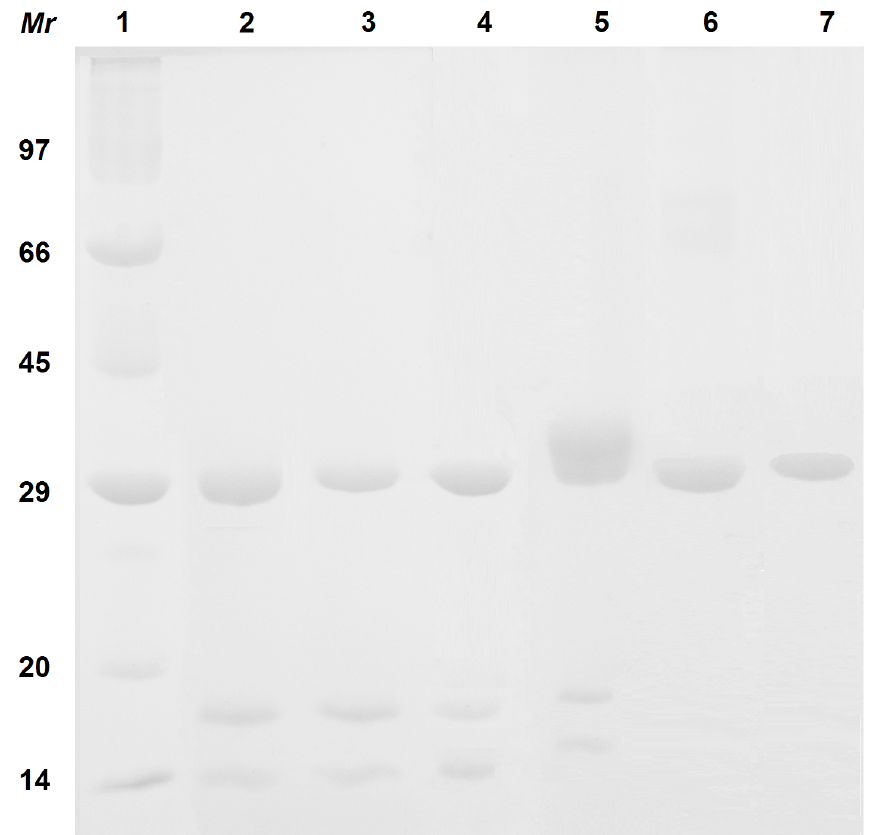
Figure 1. SDS-PAGE of the purified lectins. (1) Molecular mass markers: phosphorylase b, 97 kDa; bovine serum albumin, 66 kDa; ovalbumin, 45 kDa; carbonic